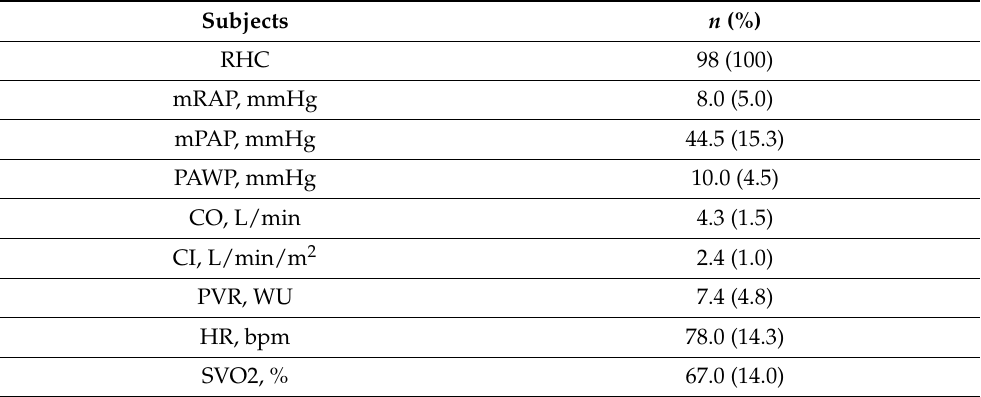
Table 3. Baseline Hemodynamic parameters and Echocardiographic